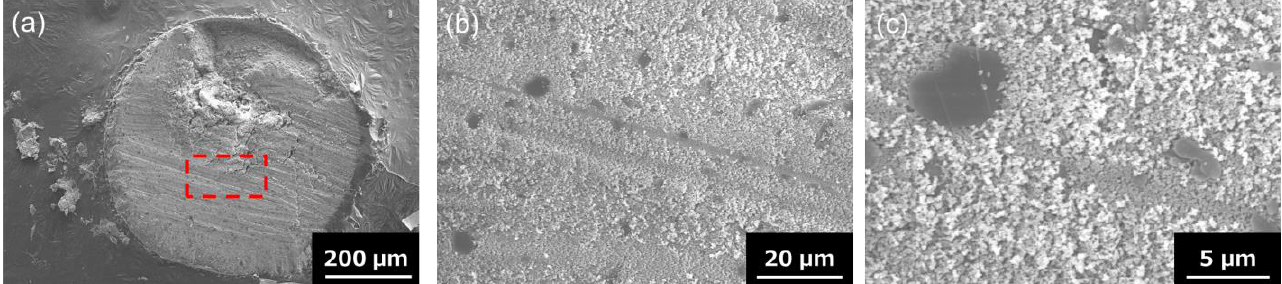
Figure 2. Optical microscope images of the dried ( a ) Al 2 O 3 granules and ( b ) Al 2 O 3 – hBN CS composites granules. Insets are representative schematics for their internal microstructure.